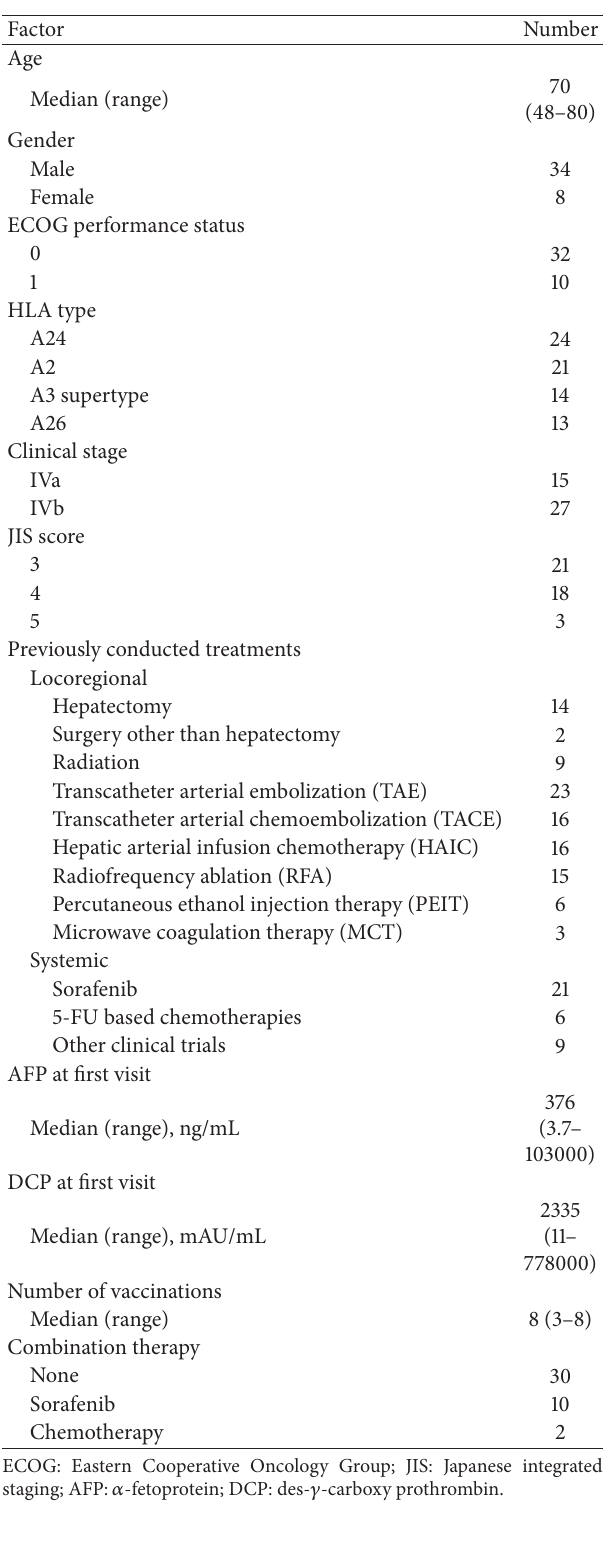
Table 1: Patients’ characteristics ( 𝑛 = 42